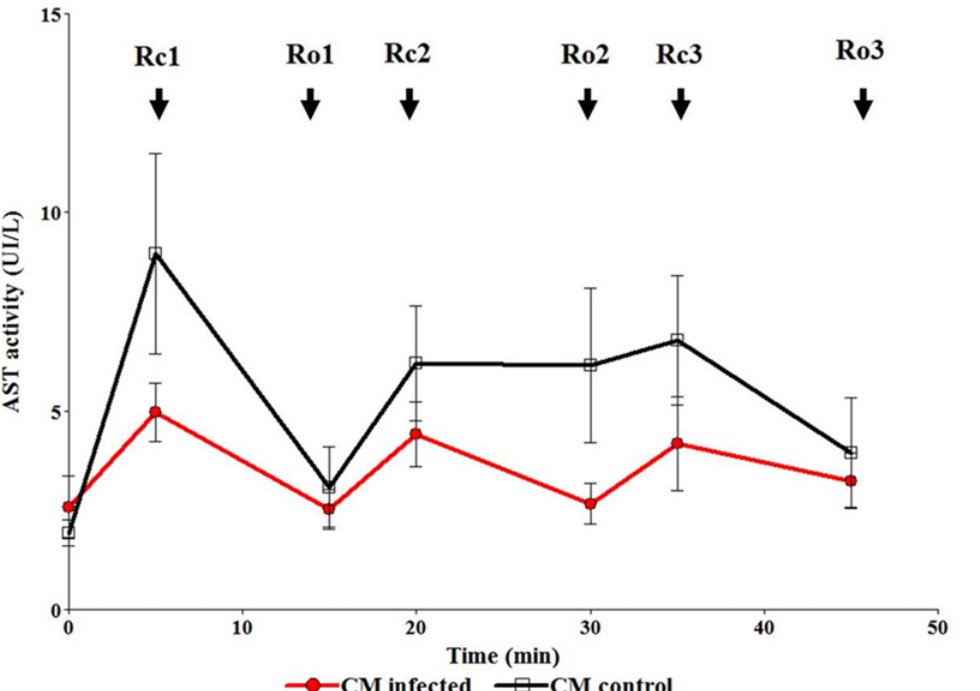
Fig 4. Determination of Aspartate aminotransferase activity (AST) in coronary effluent during the recirculation-reoxygenation cycles. Rc: recirculation cycle and Ro: reoxigenation cycle. The arrows identify the times at which the samples were taken of the recirculation-reoxigenation stages and are identified as Rc1 (recirculation 1), Rc2 (recirculation 2), Rc3 (recirculation 3), Rc1 (reoxygenation 1), Rc2 (reoxygenation 2) and Rc3 (reoxygenation 3). The graph shows the enzyme activity averages of the perfusato samples from hearts treated with CM control (n = 4) and CM infected (n = 5).